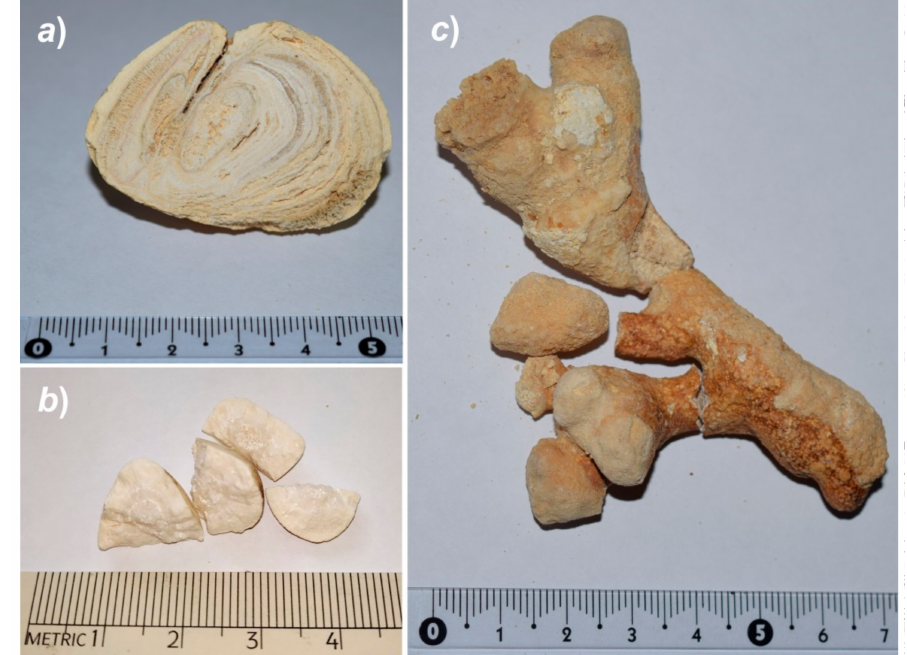
Figure 1. Infectious renal stones: ( a ) Apatite–struvite–brushite, ( b ) struvite, and ( c )